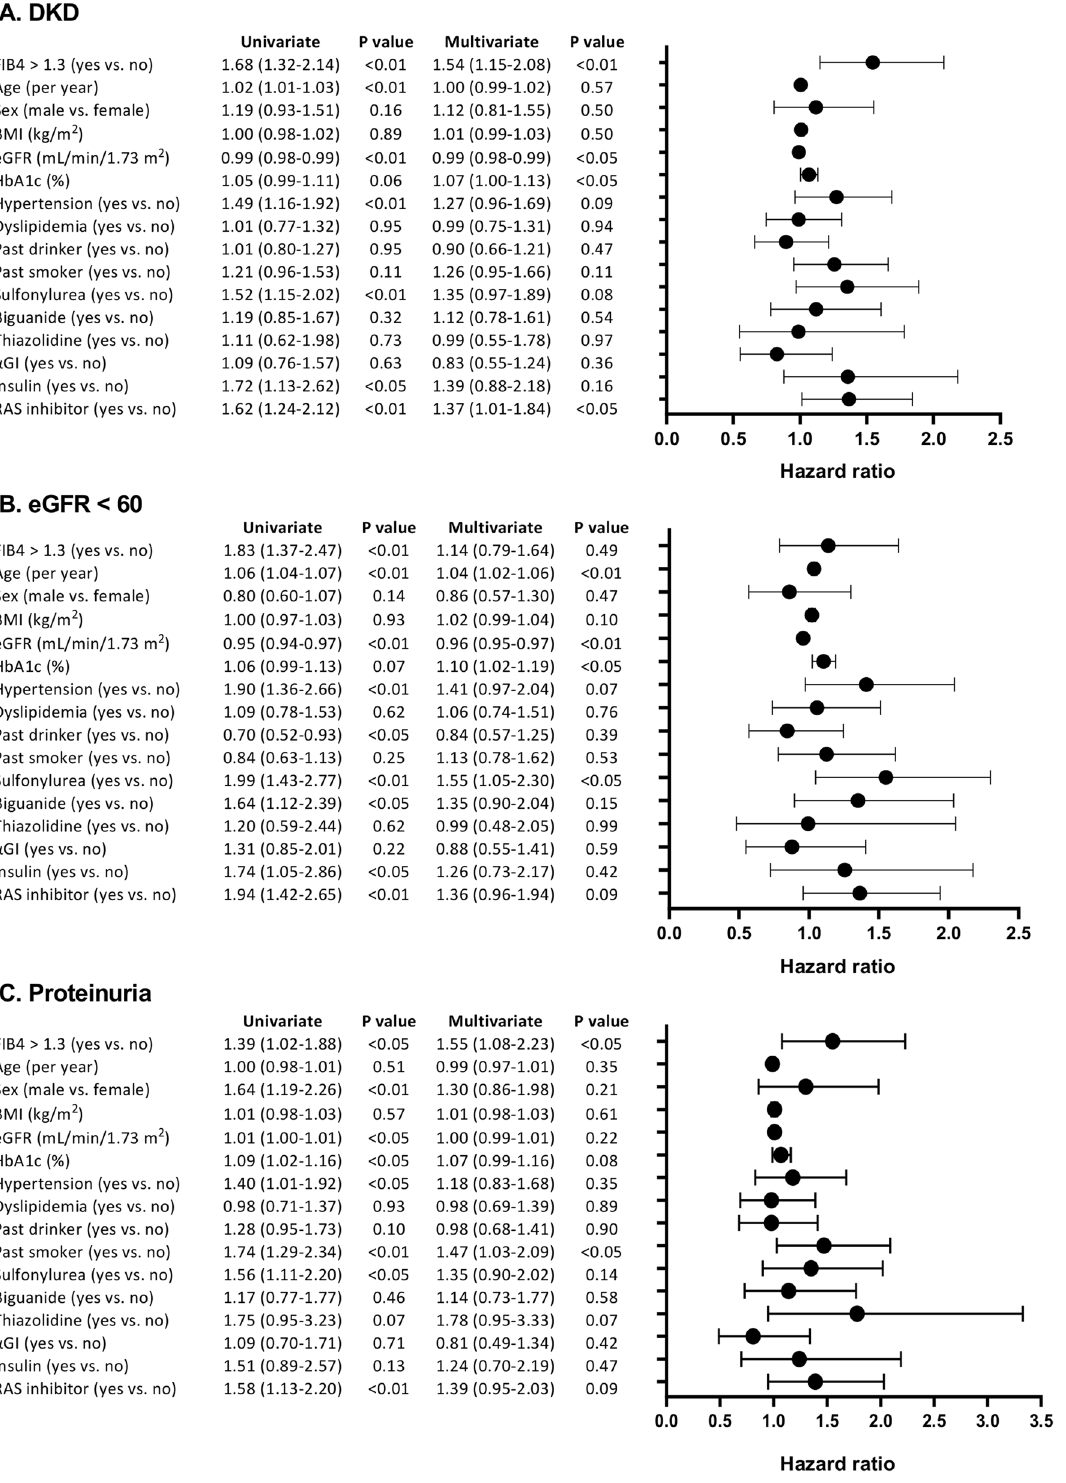
Figure 3. Univariate and Cox proportional hazard ratios of FIB4 index > 1.3 for the development of ( A ) diabetic kidney disease (DKD: eGFR < 60 mL/min/1.73 m 2 or proteinuria), ( B ) eGFR < 60 mL/min/1.73 m 2 , and ( C ) proteinuria in type 2 diabetic patients. Cox proportional hazard models were adjusted for age, sex, BMI, baseline HbA1c, baseline eGFR, smoking and drinking status (current or past), comorbidities (hypertension, dyslipidemia) and anti-diabetic and anti-hypertensive medications. 95% CI 95% confidence